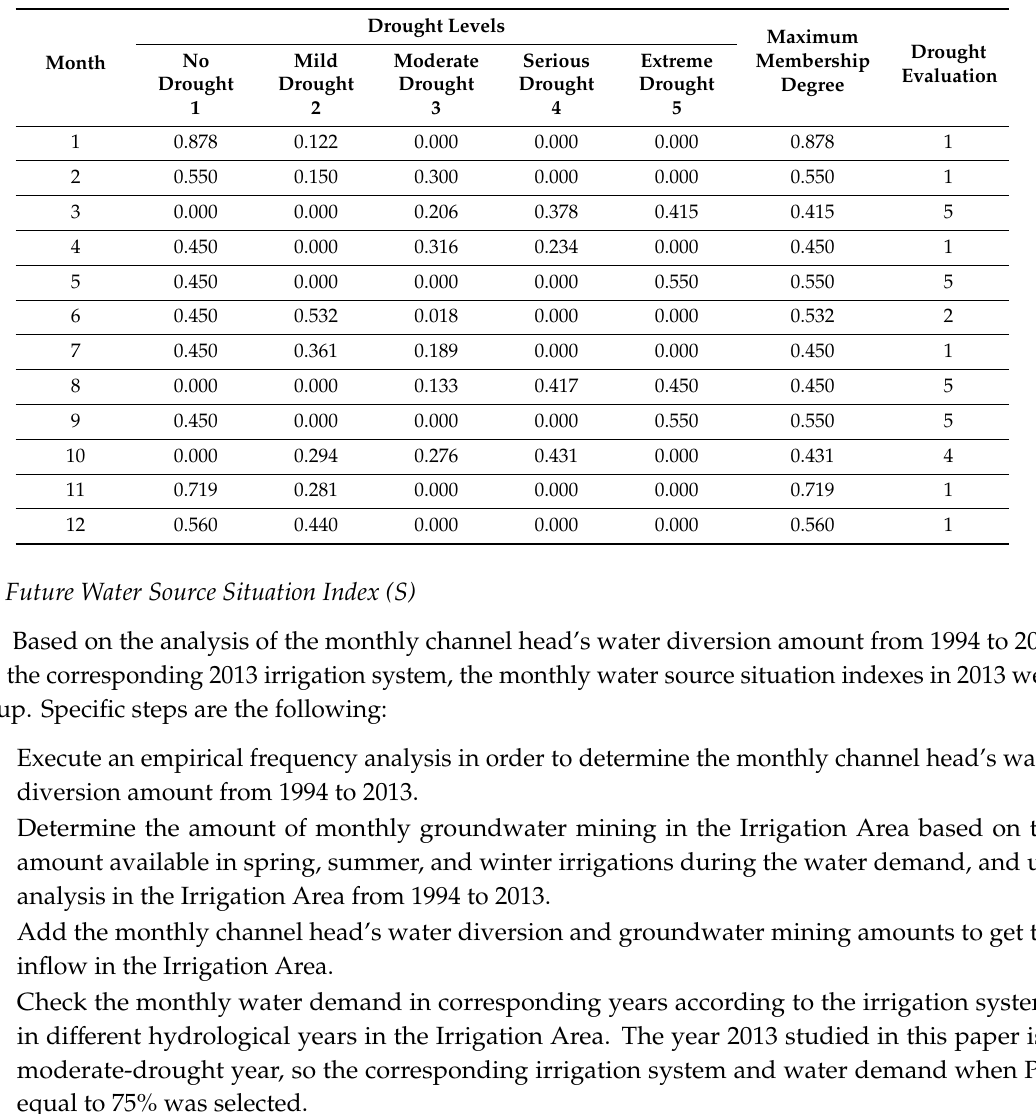
Table 11. Monthly drought evaluation results for the Jinghui Channel Irrigation Area in 2013.